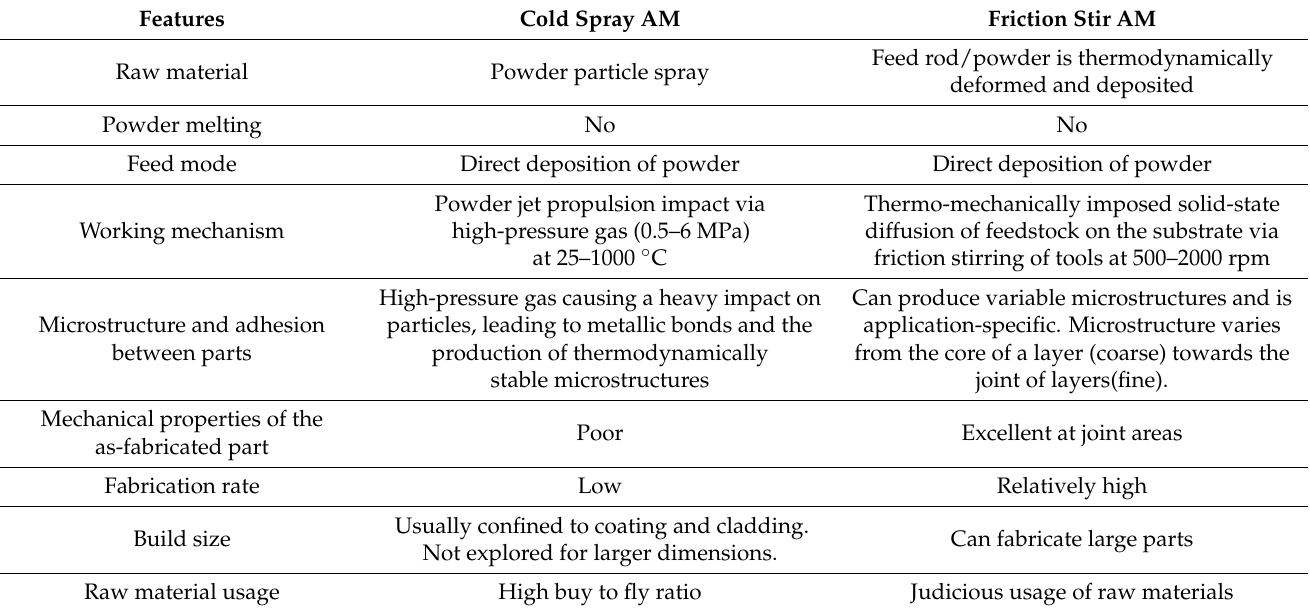
Table 2. Summary of cold spray AM and friction stir AM processes